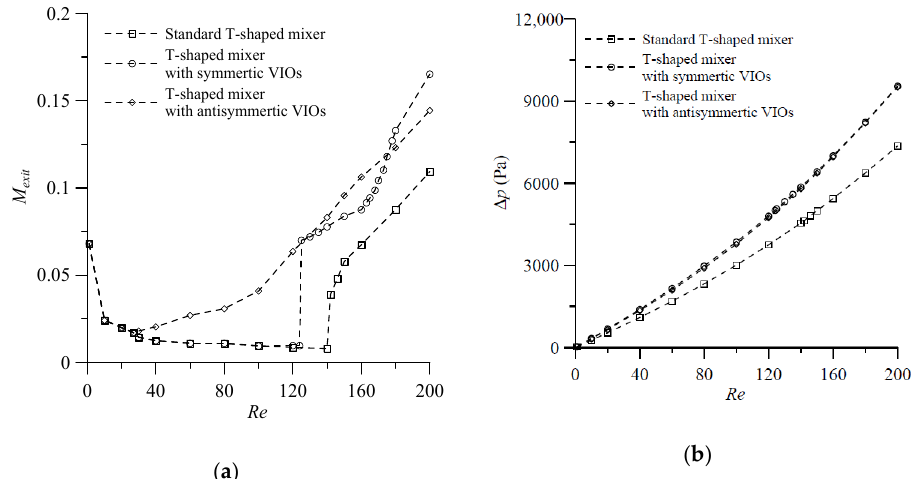
Figure 13. ( a ) Degree of mixing at the exit, and ( b ) pressure drop versus Reynolds number for the proposed mixers with VIOs and a standard planar T-shaped mixer.